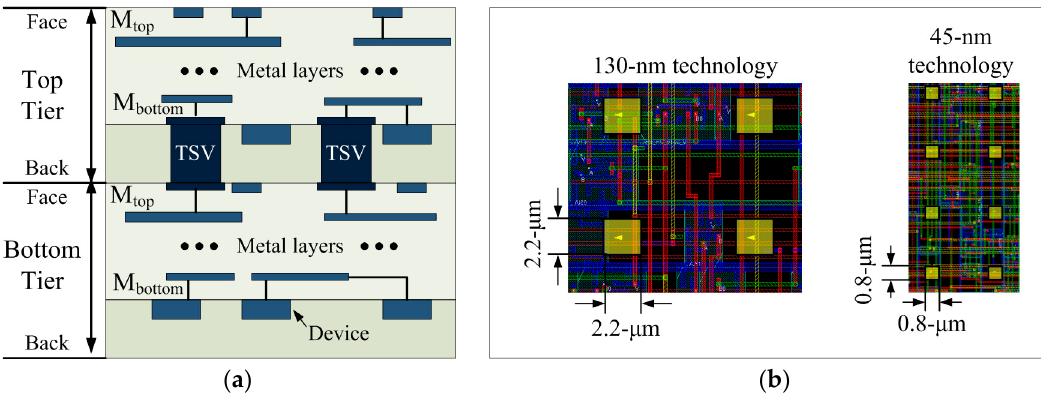
Figure 5. Via-first bonding technology used in this paper: ( a ) Side view of via-first TSVs; and ( b ) top-down view of TSVs.